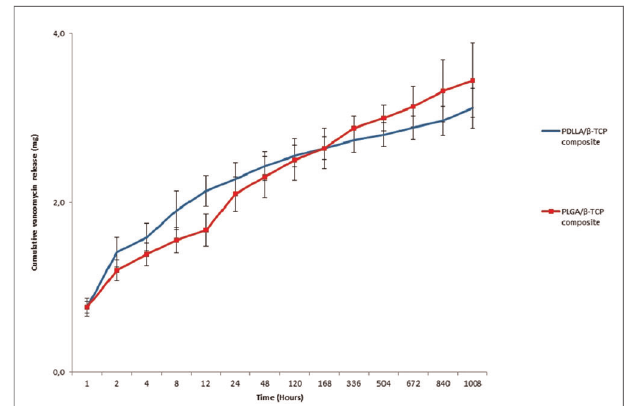
FIGURE 6 | Proliferation of the MSC and SaOS-2 cells in days 1, 3, and 7 according to the absorbance of WST-1 at 450 nm. PDLLA, poly( D , L -lactide); PLGA, poly( D , L -lactide-co-glycolide); β -TCP, beta-tricalcium phosphate; SaOS-2, osteosarcoma cell; hBM-MSC, human bone marrow-derived mesenchymal stem cell; WST, water soluble tetrazolium salt.